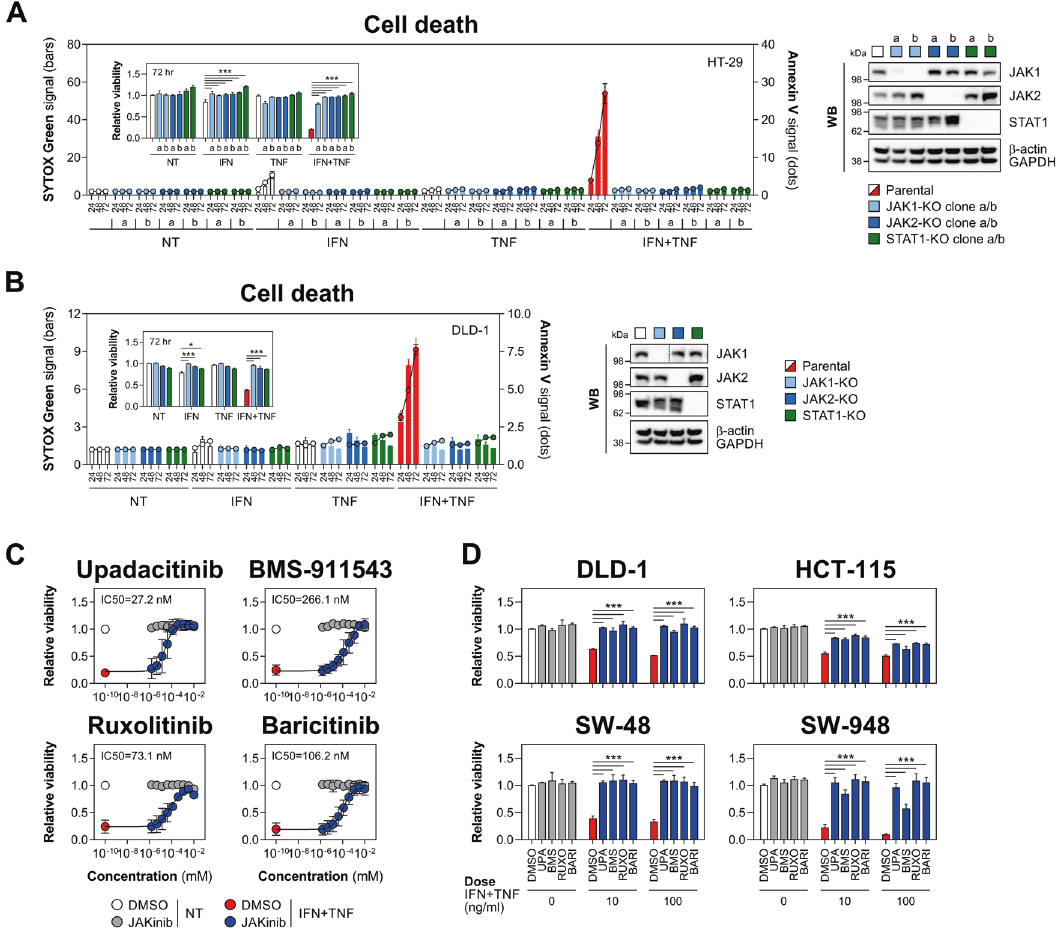
Fig. 3 JAK1/2 inhibition protects IECs from IFN- γ /TNF- α . A Parental, JAK1, JAK2 or STAT1 knockout HT-29 cells were treated with IFN- γ and/ or TNF- α (10 ng/ml each) for up to 72 h. SYTOX Green/Annexin V signals were recorded at indicated times, and relative viability was measured at 72 h (inner graph). Two knockout clones per each target (labelled as 'a' and 'b') were generated. Western blot validation of target knockout (right). B Parental, JAK1, JAK2 or STAT1 knockout DLD-1 cells were treated with IFN- γ and/or TNF- α (100 ng/ml each) for up to 72 h. SYTOX Green/Annexin V signals were recorded at indicated times, and relative viability was measured at 72 h (inner graph). Western blot validation of target knockout (right). C Relative viability of HT-29 cells pretreated for 1 h with vehicle (DMSO), JAK1-selective compound (upadacitinib), JAK2-selective compound (BMS-911543) or dual JAK1/2 inhibitors (ruxolitinib or baricitinib) starting at 10 μ M with threefold dilutions down to 1.52 nM, followed by IFN- γ /TNF- α (10 ng/ml each) for 72 h. Data were mean ± SD of n = 3 independent experiments. D Relative viability of DLD-1, HCT-115, SW-48 and SW-948 cells pretreated for 1 h with DMSO or the indicated JAK inhibitors (1 μ M each), followed by IFN- γ /TNF- α (10 or 100 ng/ml each) for 72 h. Unless speci fi ed otherwise, data were mean ± SEM of n = 3 independent experiments. * p < 0.05 and *** p < 0.001 (two-way ANOVA with Tukey ’ s multiple comparisons test). NT non-treated, KO knockout, JAKinib JAK inhibitor, UPA upadacitinib, BMS BMS-911543, RUXO ruxolitinib, BARI con fi rmed JAK1/2 as the principal and nonredundant drivers of synergistic IEC killing by IFN- γ /TNF- α .